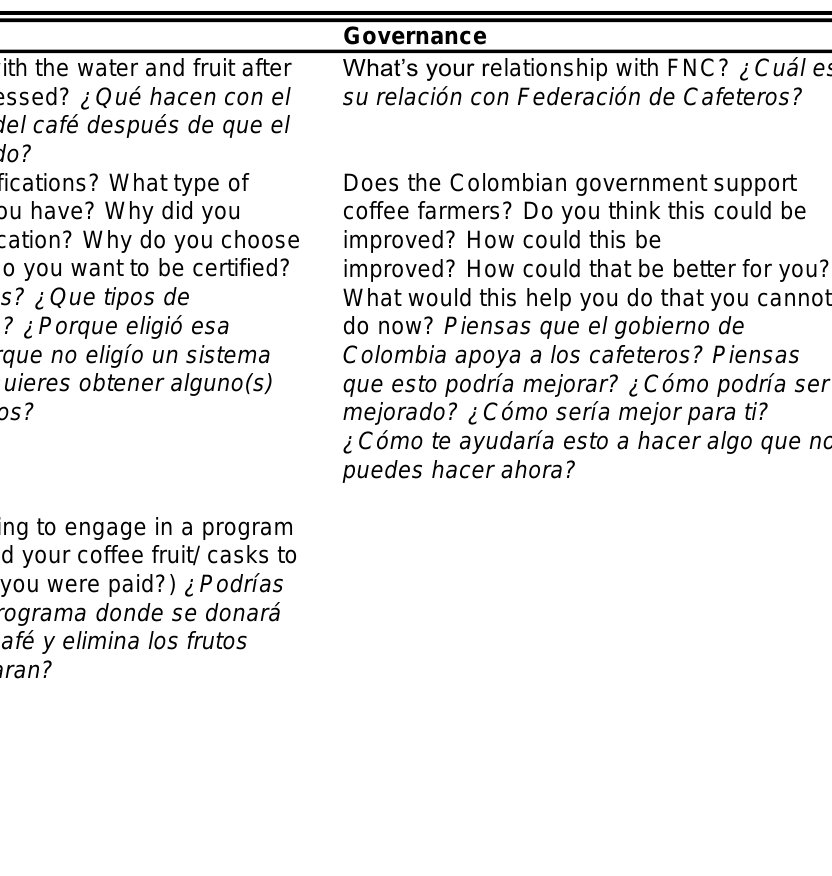
Appendix 1: Focal Groups questions which we used to guide discussions. We allowed for freedom of discussion to flow throughout focal group interviews depending on the groups interest of information of particularly topics. Documented in both English and Spanish. Table A1.1. Focal Group discussion questions, Part